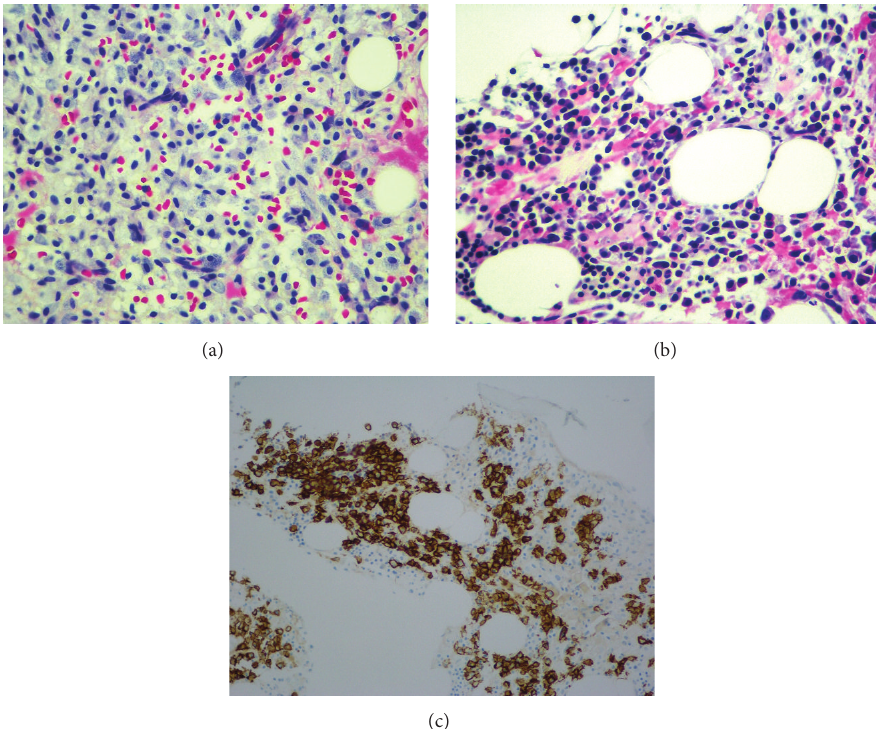
Figure 1: Bone marrow biopsy showing an infiltrate of spindle-shaped mast cells (a) comprising 50% of the marrow. Plasma cell infiltrate (b) occupying 30% of the remaining marrow, with an image showing CD138 staining (c).